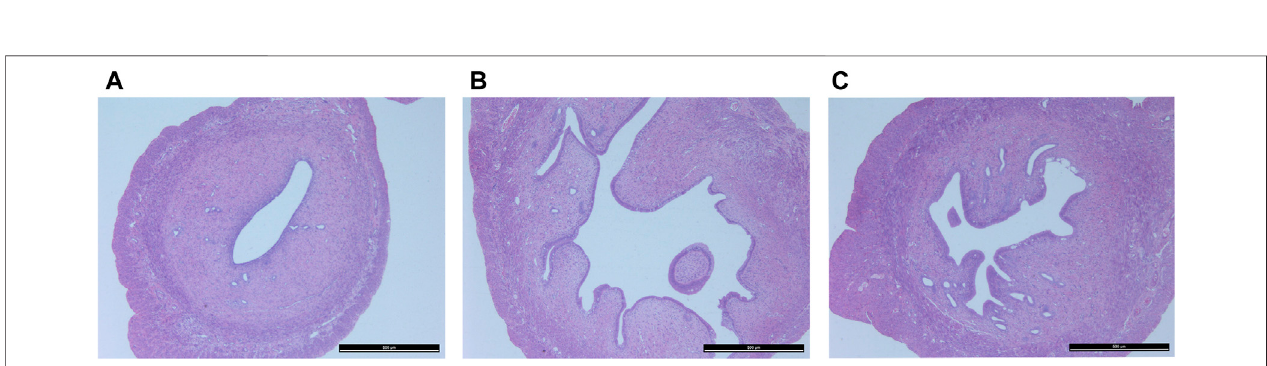
FIGURE 3 | Histopathological section of uterus (A) Control group (B) Model group (C) GZFL group.